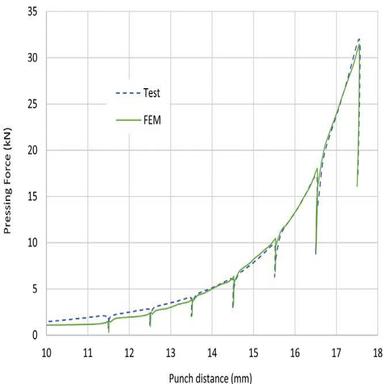
Pressing force as a function of punch distance in experiments and simulation with currently determined material parameters. The average relative density d in the specimen (in relation to sintered density) is 41.2% at the first unloading step and 58.4% at last unloading step.